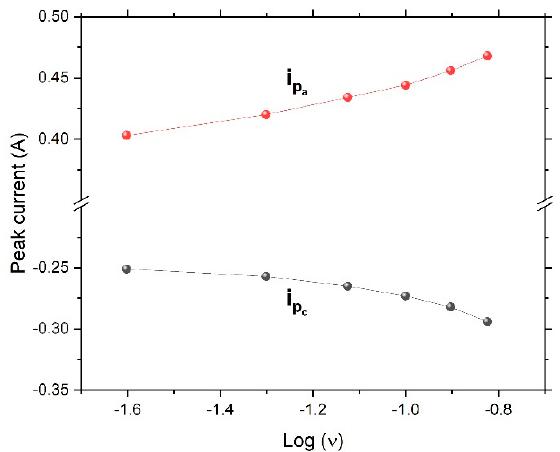
Figure 7. Trumpet-shaped plot of peak current versus the logarithm of the scan rate, ν (V/s), indicating reversible (low-barrier) electron-transfer kinetics (i pa and i pc are the anodic and cathodic peak currents, respectively).